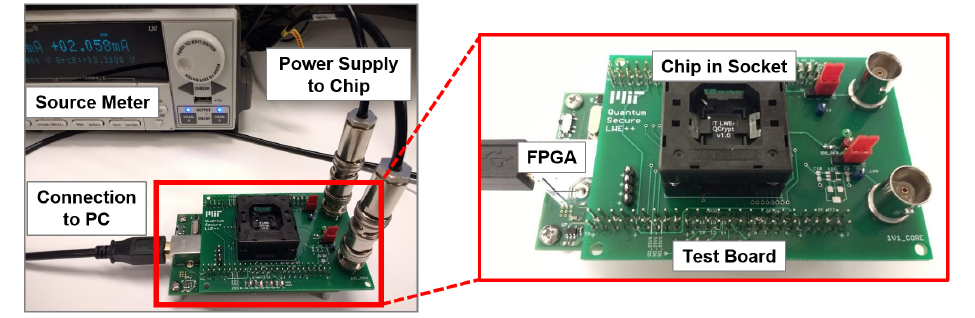
Figure 12: Measurement setup with our test